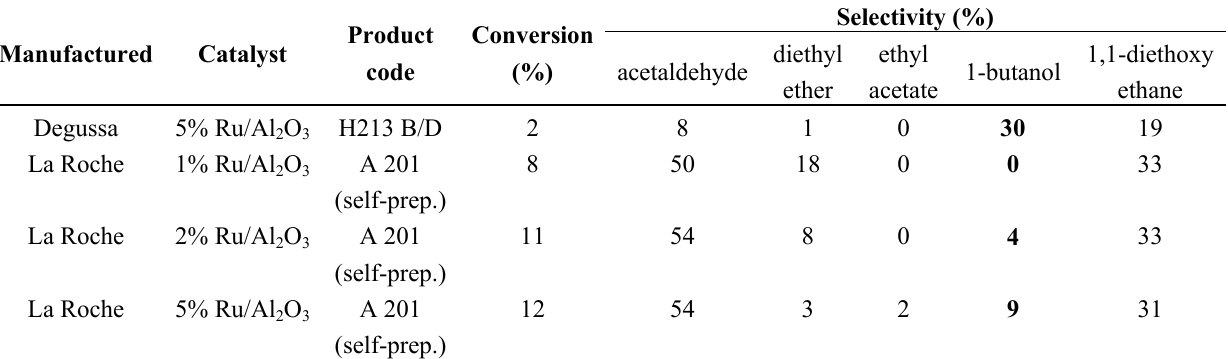
Figure 1. Transmission electron microscopy (TEM) and X-ray diffraction (XRD) images of self-prepared 5 wt% Ru/Al